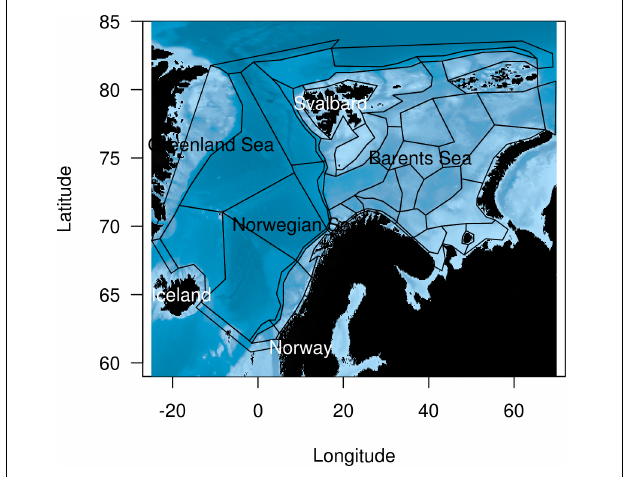
FIGURE 1 | Bathymetric map of the Northeast Atlantic showing the NOBA Atlantis model